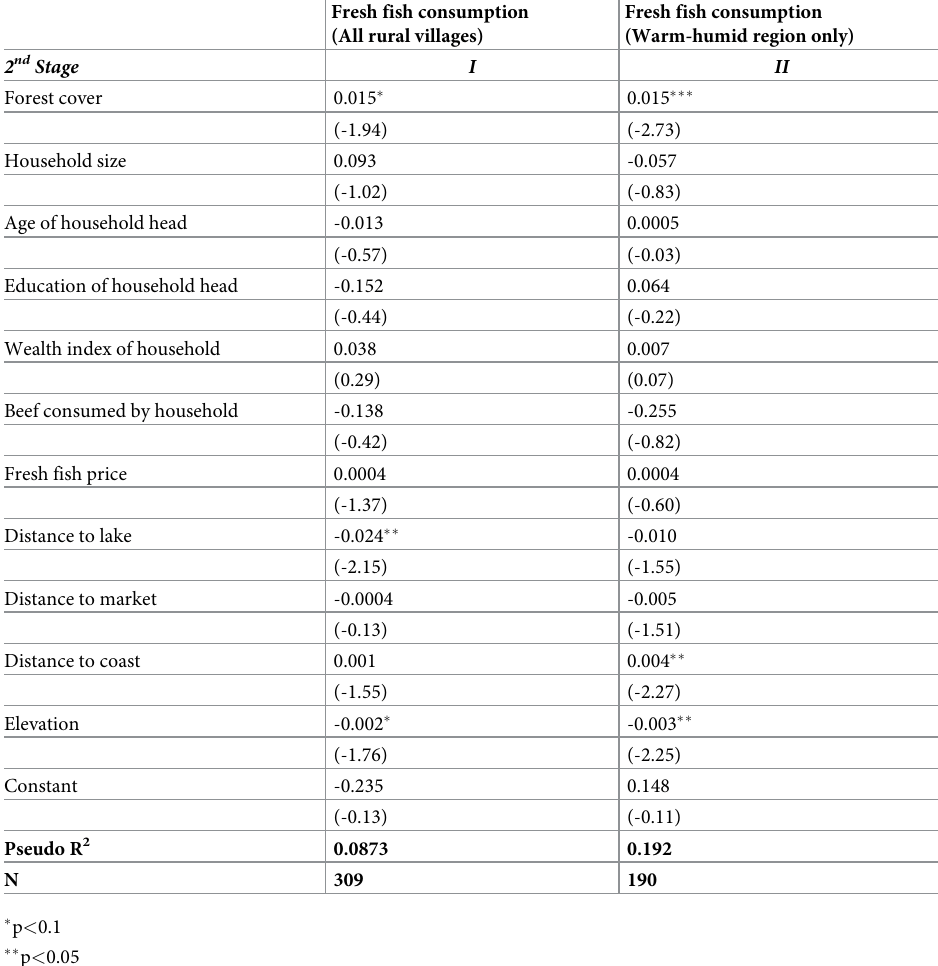
Table 3. Results from the second stage of the double hurdle model for fresh fish consumption and forest cover around rivers ( r1kmv01 ) at the village level for all rural villages (n = 309) and the in warm-humid regions of Nige- ria. Z-statistics are given in